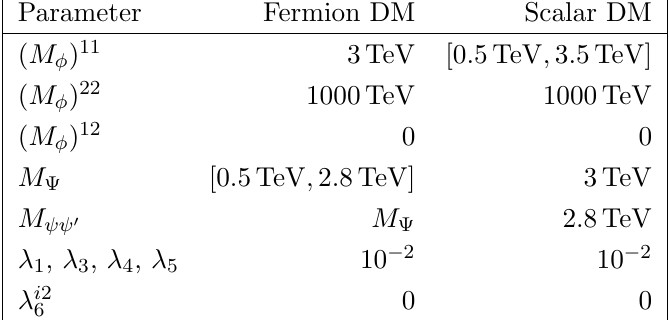
Table 3 . Mass parameters and couplings used in (cid:12)gure